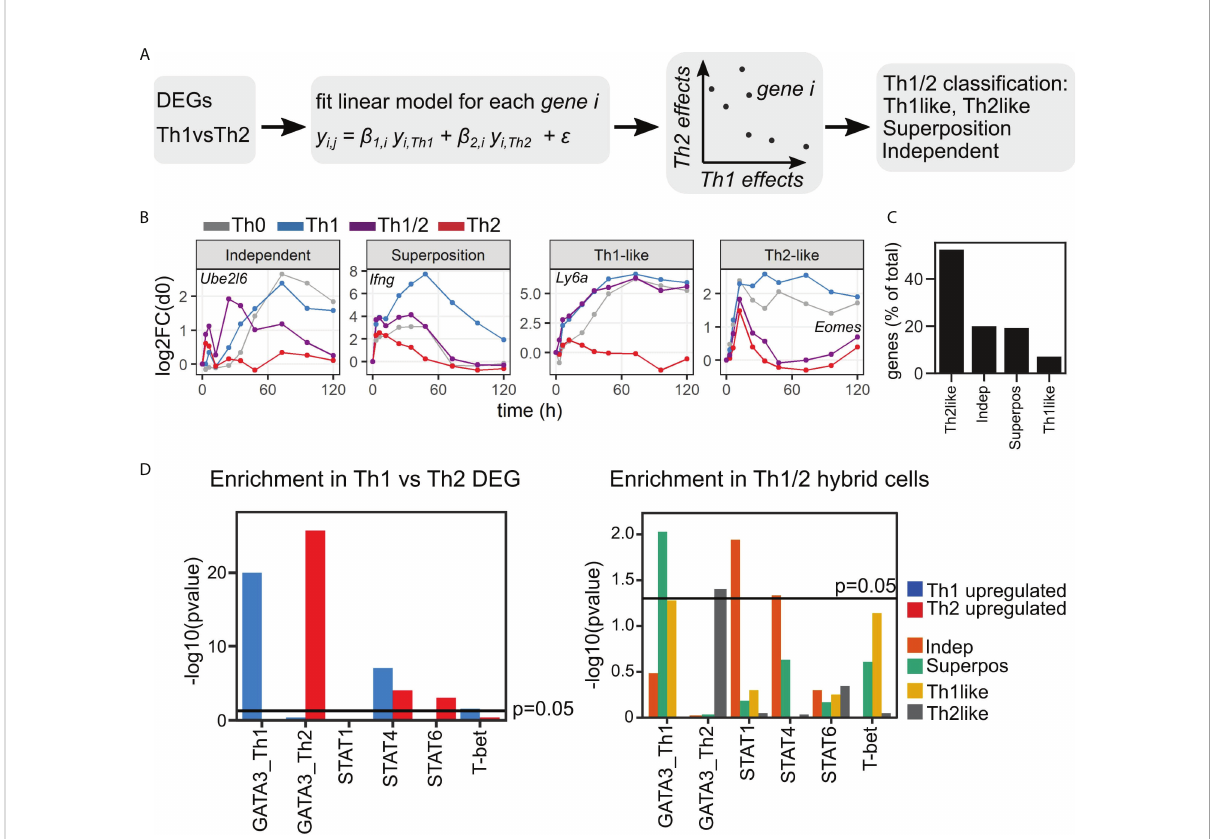
FIGURE 4 Superposition and independence of genes in Th1/2 hybrid cells. (A) Work fl ow sketch. Based on the identi fi ed qualitative Th1 vs. Th2 DEG (see Figure 3C), similarity of genes to the expression pro fi le of Th1/2 hybrid cells was assessed by a linear regression model. (B) Time courses of representative genes, and (C) quanti fi cation of gene classi fi cation into the four different categories. (D) Enrichment analysis using published transcription factor target gene sets (see text). Left: Analysis of upregulated genes in Th1 (Th2) cells, which are taken as Th1 vs. Th2 DEG with expression values higher (lower) in Th1 compared to Th2 cells. Right: Analysis of the Th1/2 hybrid transcriptional pro fi le along the gene categories obtained in (A – C)